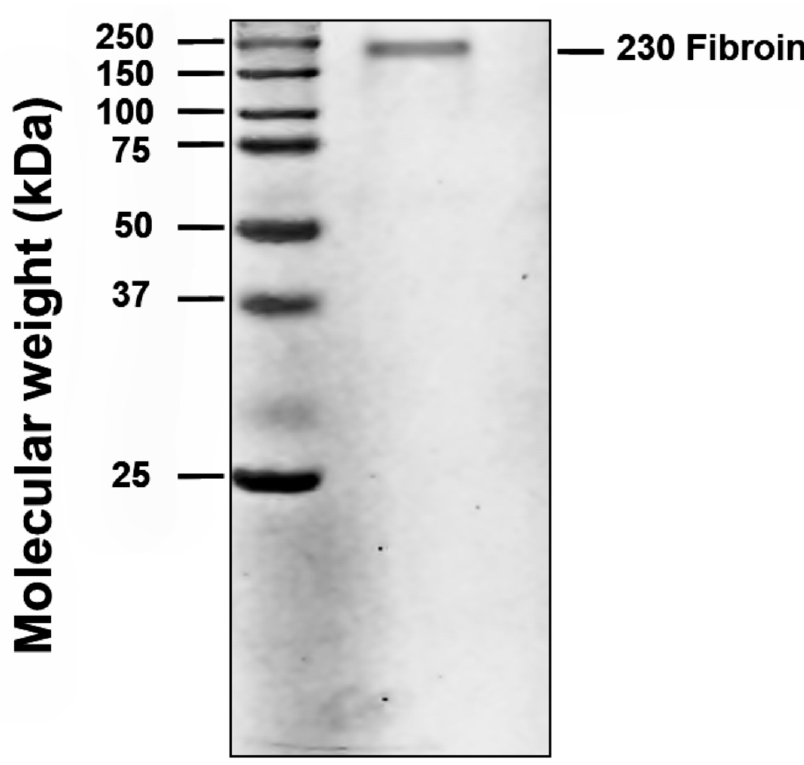
Figure 1. The molecular weight of purified Bombyx mori silk fibroin as displayed by gel electrophoresis.